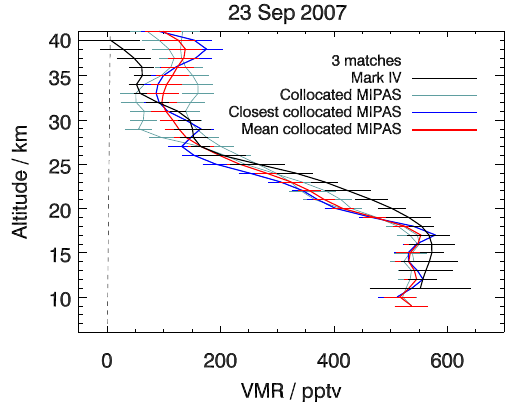
Figure 17. Comparison of one MkIV CFC-12 profile (black line) with three coincident profiles of MIPAS (blue-grayish lines). The closest (blue line) and the mean (red line) of these profiles are shown in addition. The MkIV error estimates are inferred from the fit resid-